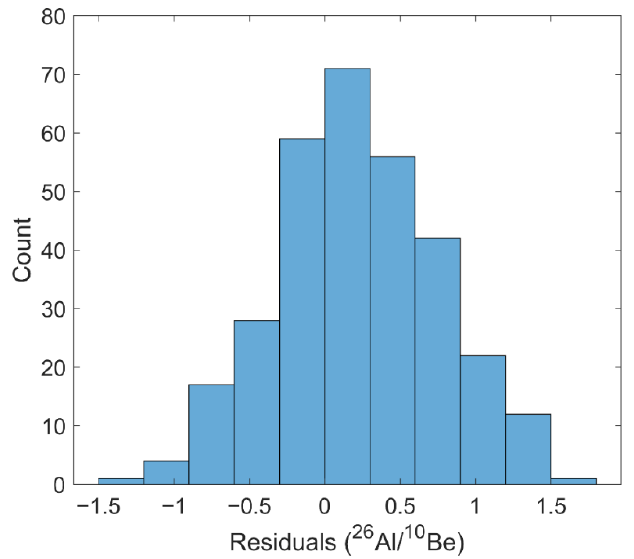
Figure 9. Residuals histogram showing differences between production ratios predicted by the LSDn scaling scheme for samples in the ICE:D compilation and measured 26 Al/ 10 Be concentration ratios. The similarity in residuals distribution seen here compared to Figure 2B, the residuals from our bi-variate model based solely on measured ratios, demonstrates the good fit of LSDn scaling to empirical data.